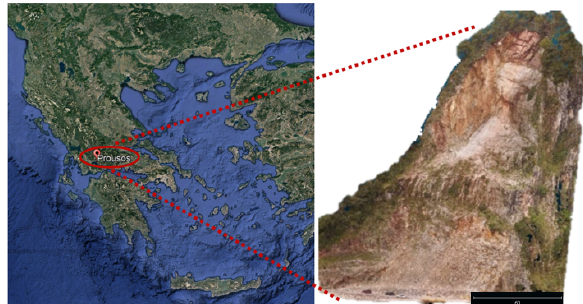
Figure 1. Index map of the Proussos area (left) and the 3D model of the landslide (right)